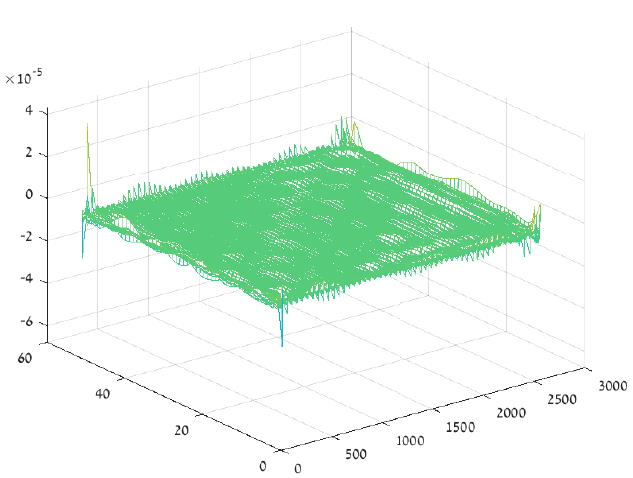
Figure 20. The 3D test function reshaped into 2D.